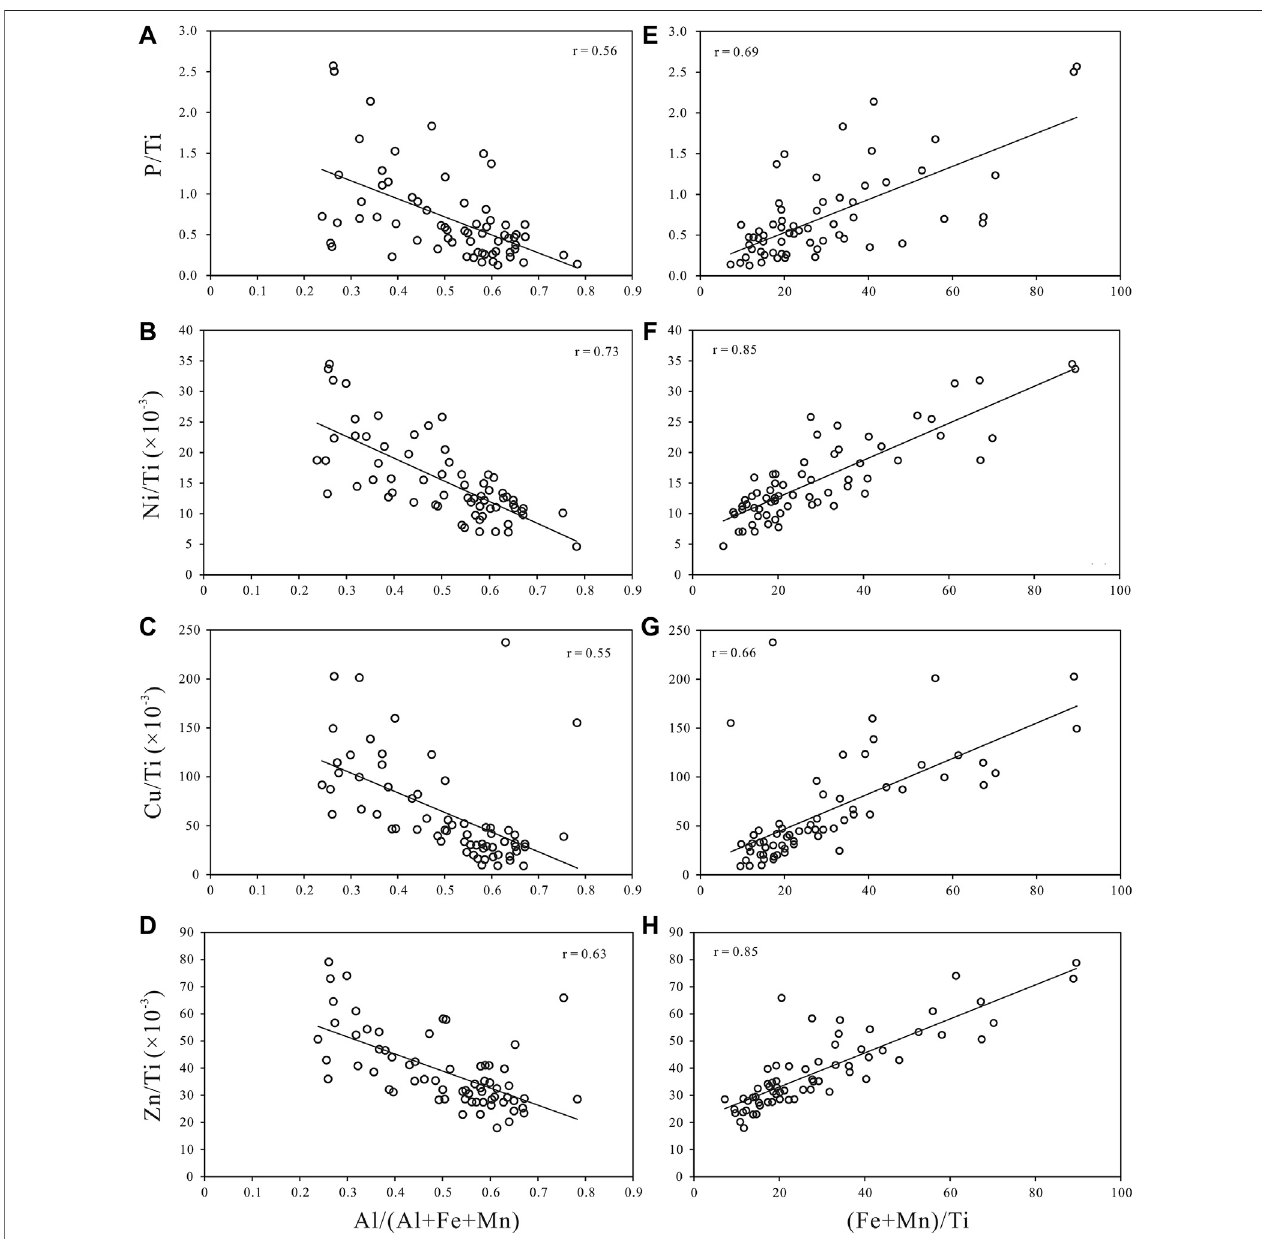
FIGURE 9 | Crossplots of paleoproductivity indicators (P/Ti, Ni/Ti, Cu/Ti, and Zn/Ti) vs. Al/(Al + Fe + Mn) and (Fe + Mn)/Ti of the Chang 7 black shale in the Ordos Basin.